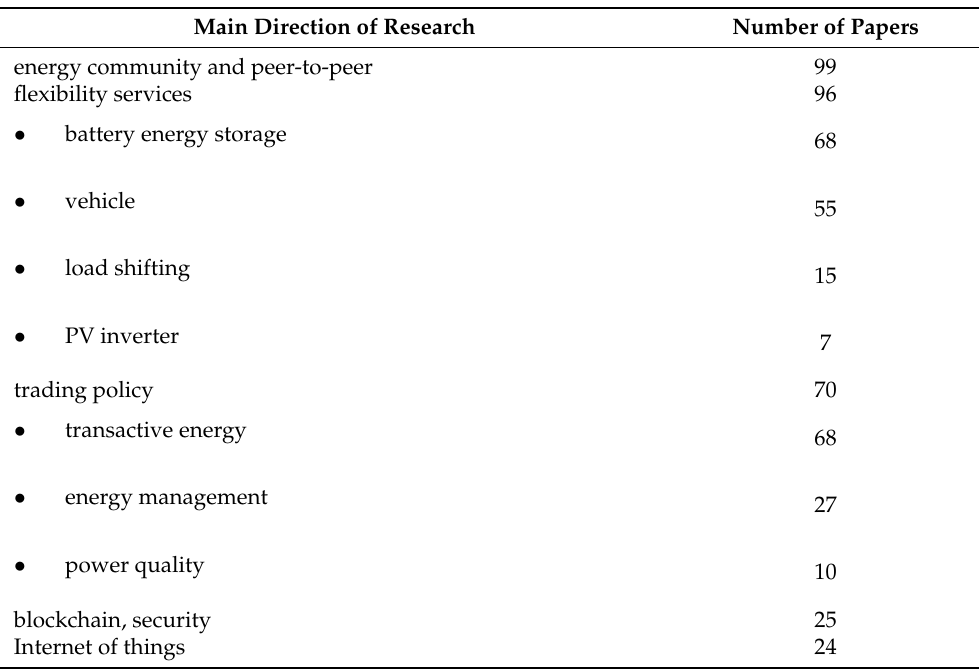
Table 2: energy community and peer ‐ to ‐ peer (P2P), flexibility services, trading policy, blockchain/security, and the Internet of things (IoT). The table indicates the number of articles assigned to a topic. Table 2. Summary of the number of articles assigned to each keyword corresponding to research directions on the topic of grid flexibility with references.